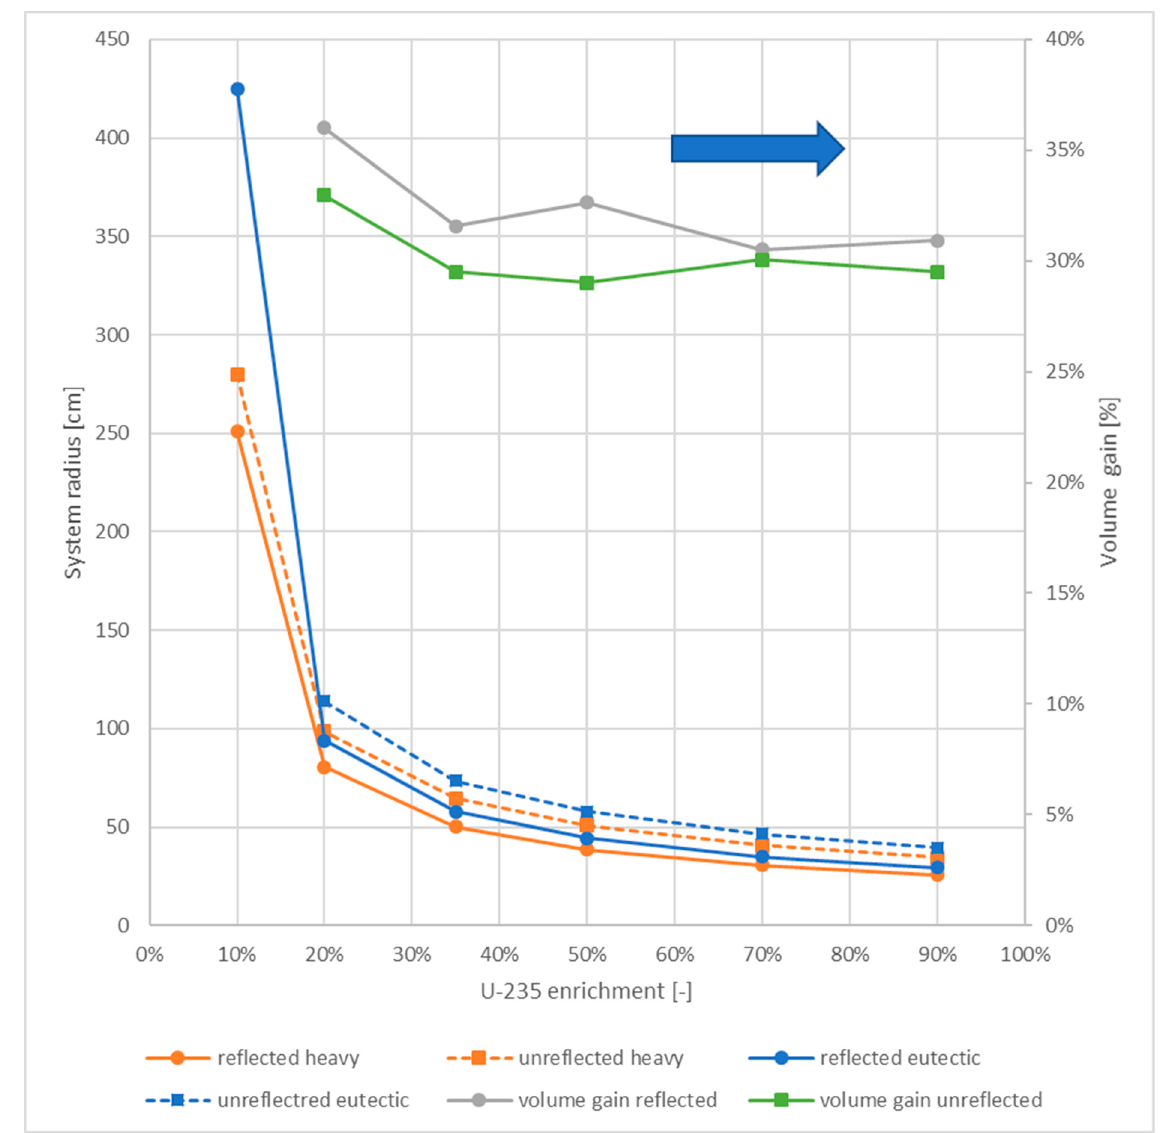
Figure 6. 2 ‐ D system radius for the eutectic and the heavy metal rich system depending on uranium enrichment for the reflected and the unreflected systems as well as the volume gain per step archived by changing from the eutectic to the heavy metal rich system (calculated through POLARIS).